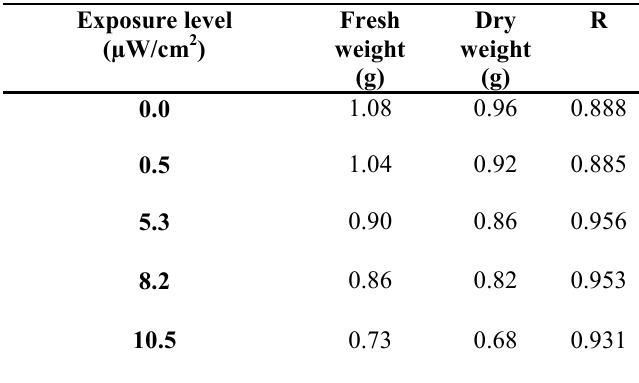
Figure 4. Leaf dimensions for all tested groups of Green Mint (i.e. length (black bars) and width (red bars)). Table 3. Fresh and dry weights of the tested Green Mint groups. Last column measures ratio of dry to fresh leaf